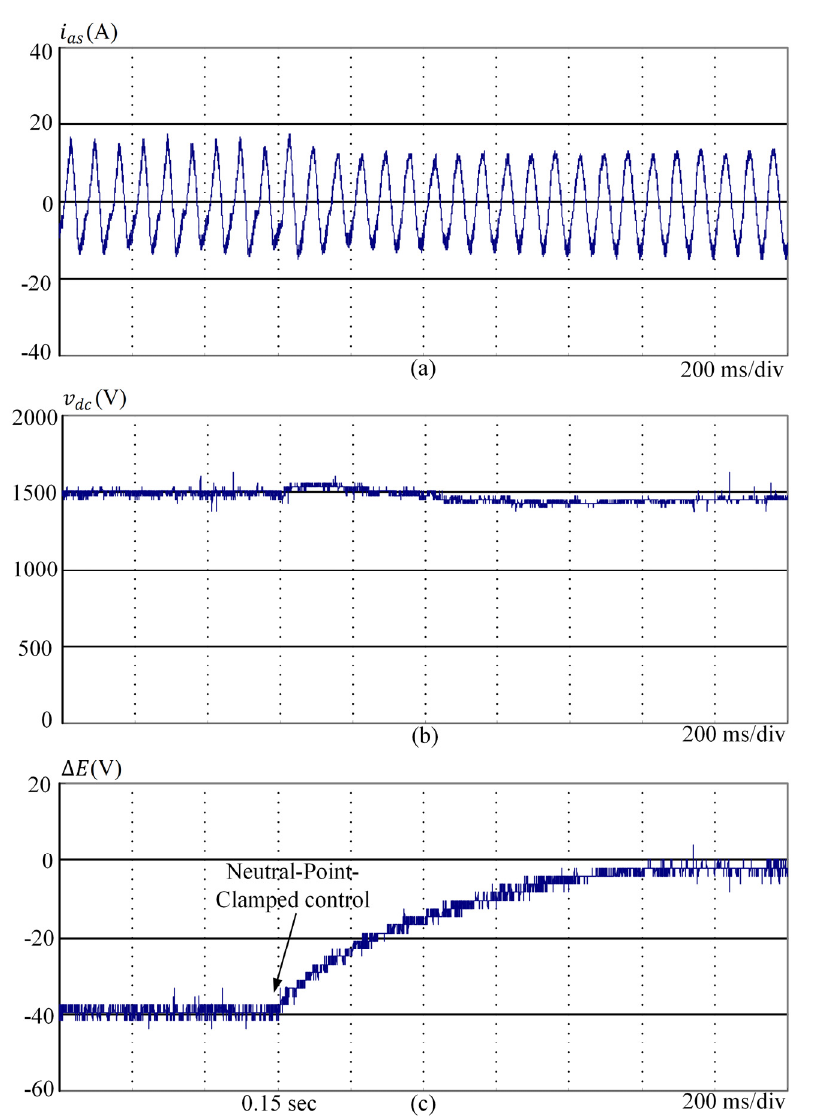
Figure 14. Experimental results of the proposed system for resistive loads (cid:1844) (cid:1844) = 60 Ω : ( a ) generator output current (cid:1861) (cid:2870) between the upper and the lower